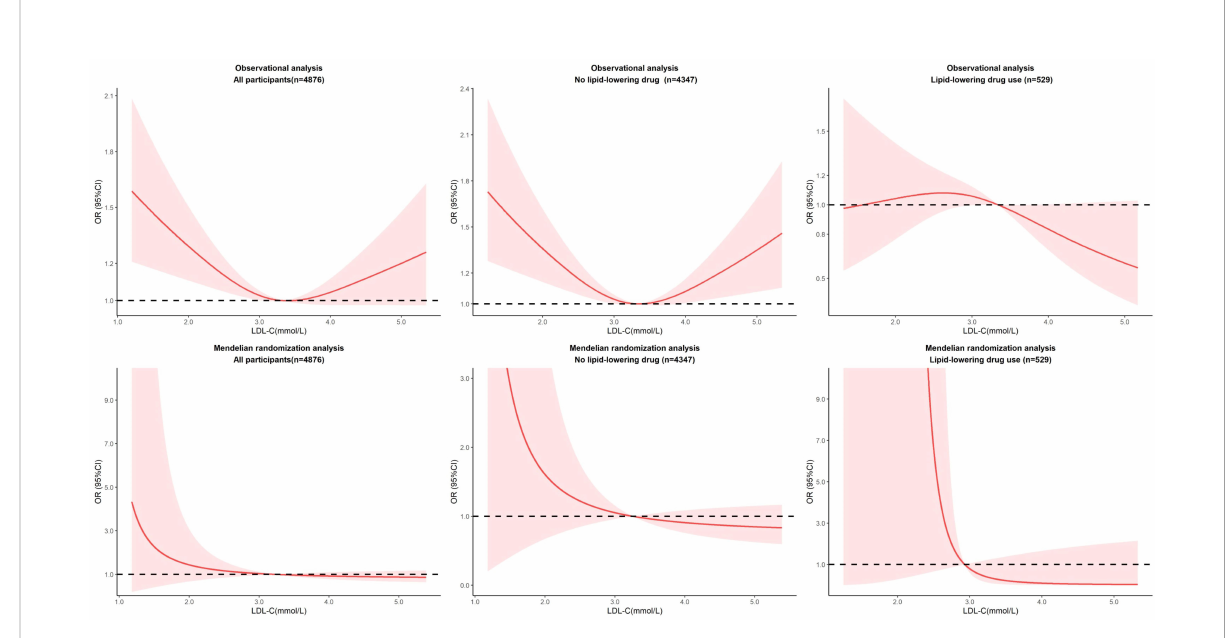
FIGURE 2 Nonlinear associations of LDL-C with the risk of diabetes in observational and MR analysis.